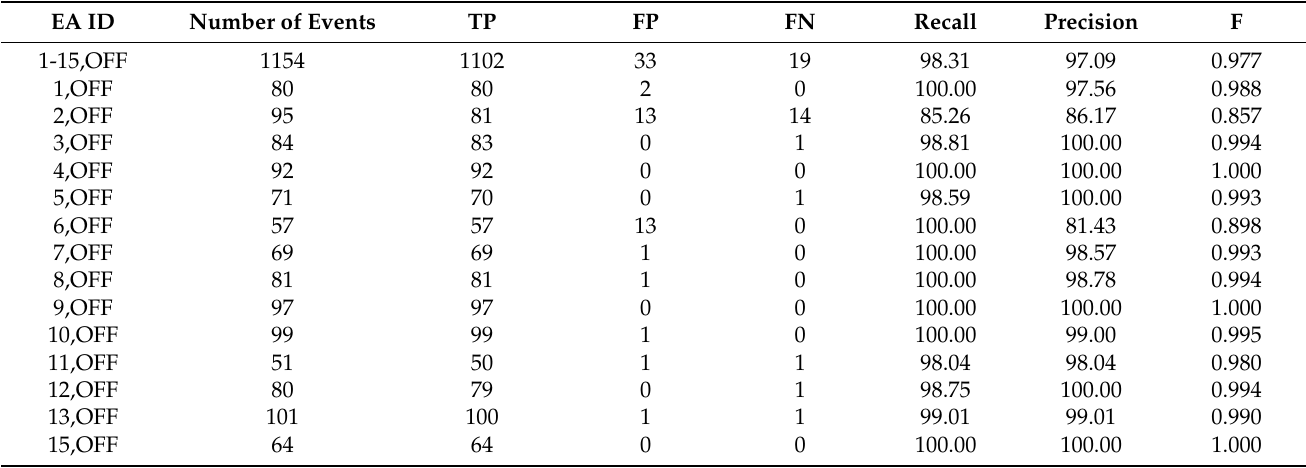
Table 8. Event detection results (switching